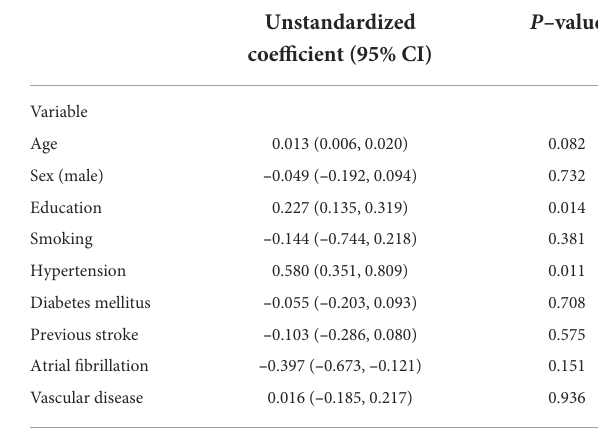
TABLE 3 Indirect associations between predictors and cognitive